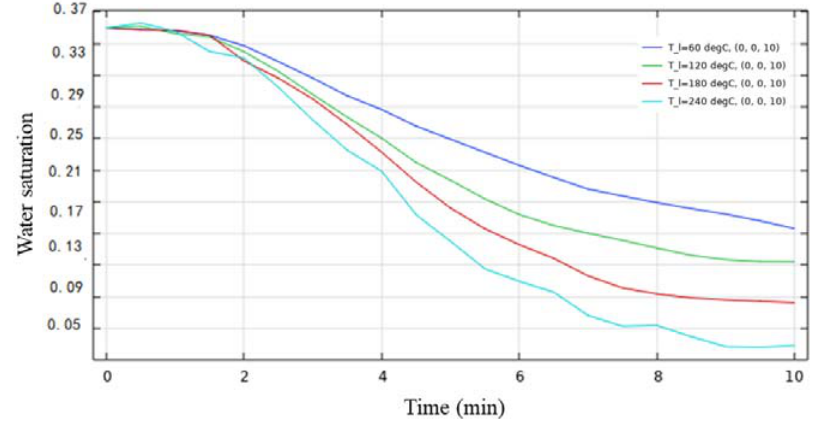
Figure 10. Residual water saturation of cores at different temperatures.